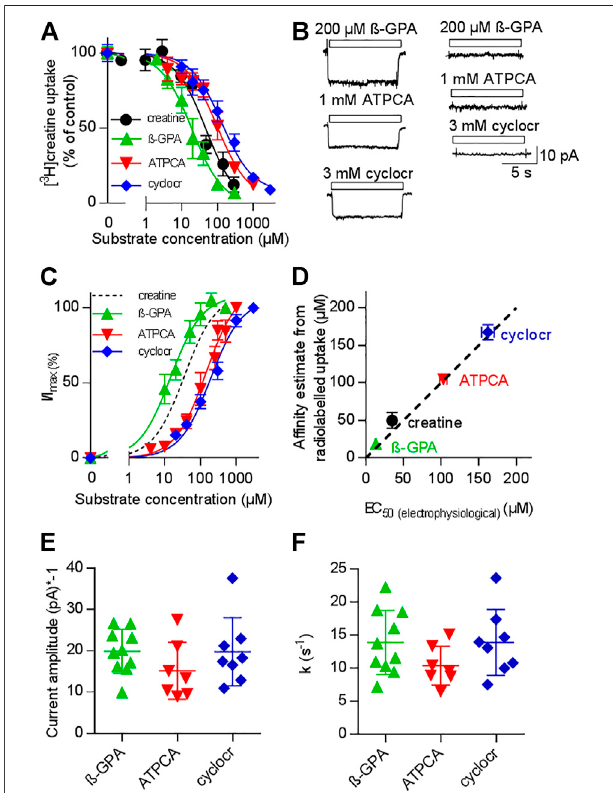
FIGURE 2 | Comparison of uptake inhibition (A,D) and CRT-1 mediated currents (B – F) evoked by different substrates. (A) Uptake of [ 3 H]creatine by HEK293 cells transiently expressing CRT-1 in absence and presence of increasing concentrations of CRT-1 substrates creatine (black circles), β -guaninidinopropionate ( β -GPA, green upward triangles), 2-amino-1,4,5,6- tetrahydropyrimidine-5-carboxylic acid (ATPCA, red downward triangles) and cyclocreatine (cyclocr, blue diamonds). Speci fi c [ 3 H]creatine uptake in the presence of competing substrates was normalized to the uptake in their absence. This control uptake was 14.7 ± 1.7 pmol min − 1 .10 – 6 cells and set to